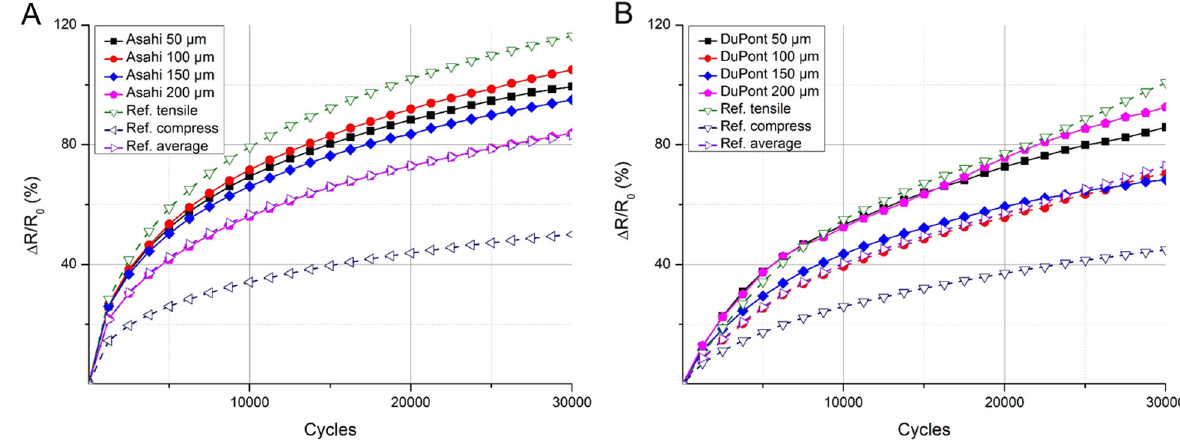
Fig. 3 Resistance vs. bending cycles. a Asahi samples bending results. Initial resistance ( R 0 ) for each case: 50 µm, 13.4 Ω ; 100 µm, 12.8 Ω ; 150 µm, 11.9 Ω ; 200 µm, 11.5 Ω ; Reference tensile, 10.7 Ω ; Reference compress 10.5 Ω . b DuPont samples bending results. Initial resistance ( R 0 ) for each case: 50 µm, 16.9 Ω ; 100 µm, 17.6 Ω ; 150 µm, 20.0 Ω ; 200 µm, 12.3 Ω ; Reference tensile, 9.9 Ω ; Reference compress 15.5 Ω .